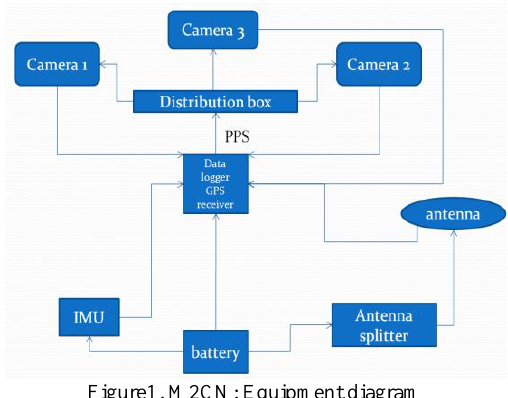
Figure1. M2CN: Equipment